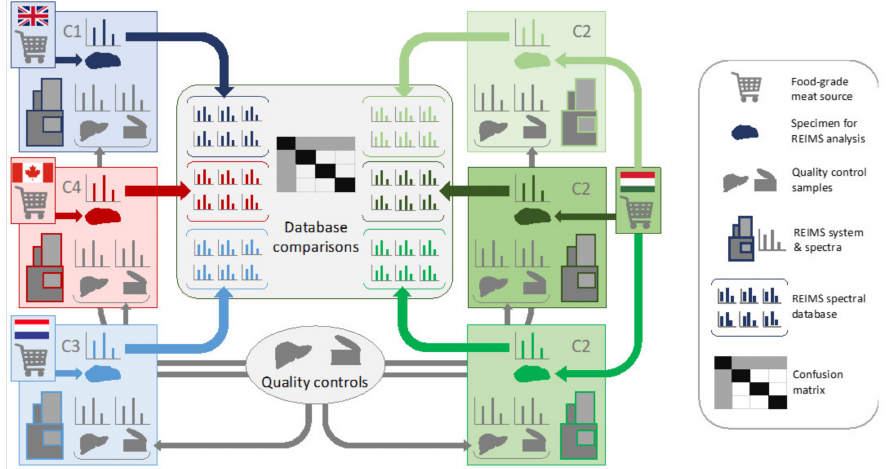
Figure 1. Multicenter ring trial for testing of REIMS methodology. Four consortium sites comprised: Imperial College London (Center 1, C1); Waters Research Center, Budapest, Hungary (C2); Maastricht MultiModal Molecular Imaging Institute, Maastricht The Netherlands (C3); and Queen’s University, Kingston, Canada (C4). Two single-source reference materials and four types of local food-grade meat were analyzed by the four centers, and classification models were based on a single center. Data was tested against data from the other centers. Reference material analyzed by all four centers comprised two batches of pork liver and meat homogenate (National Institute of Standards and Technology (NIST), Standard reference material 1546a). Local sources of food-grade meat included calf liver, chicken liver, chicken breast and turkey breast. Three different instruments were used to analyze the food grade meat at